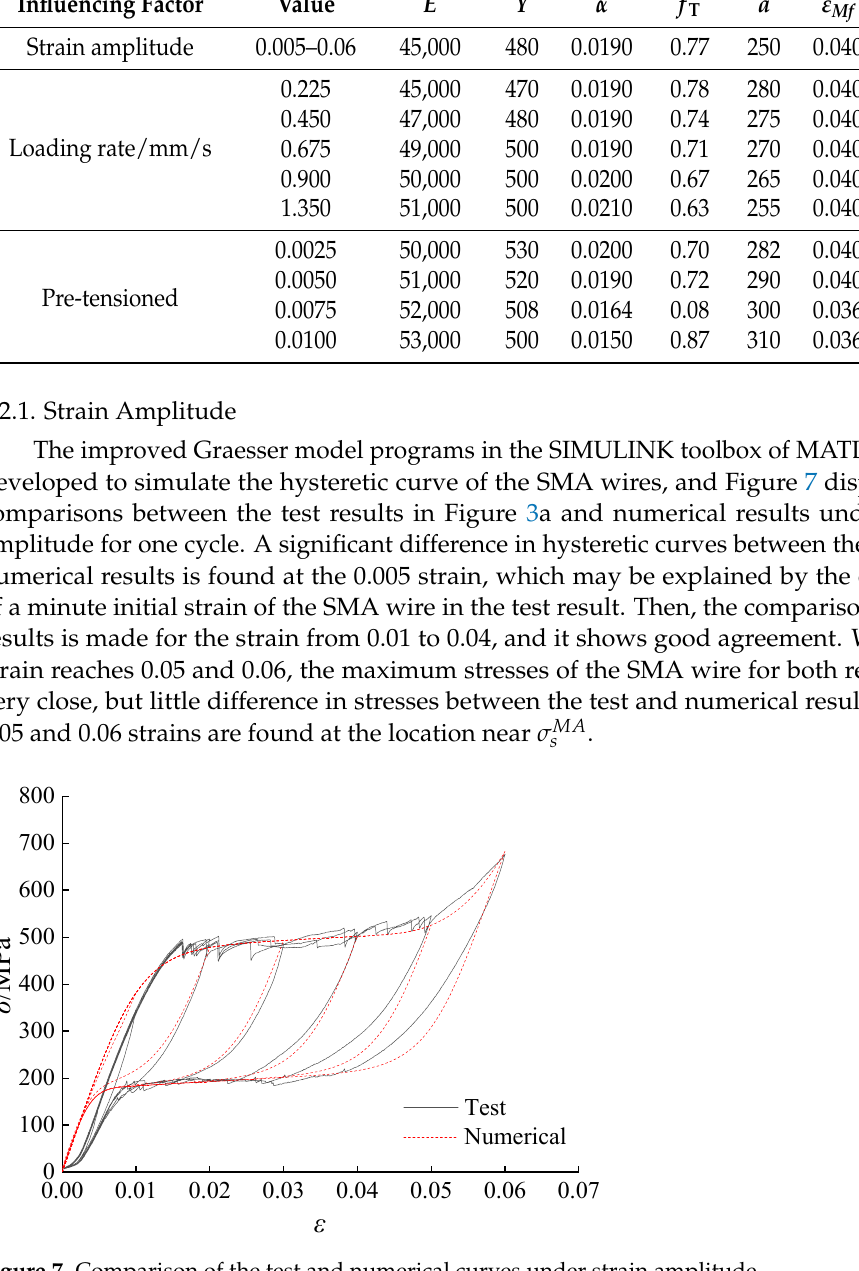
Table 2. The parameters for each mechanical model.